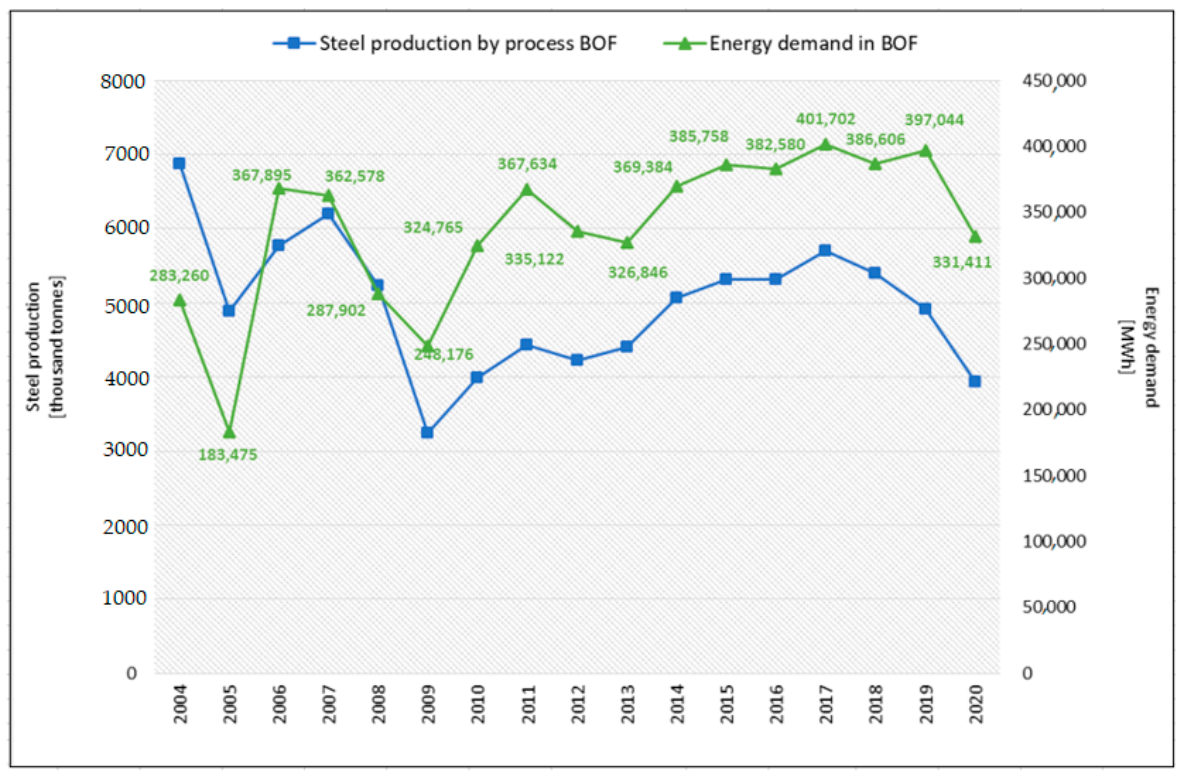
Figure 11. Total energy demand in the EAF process in Poland from 2004 to 2020. Source: Own elab- oration.